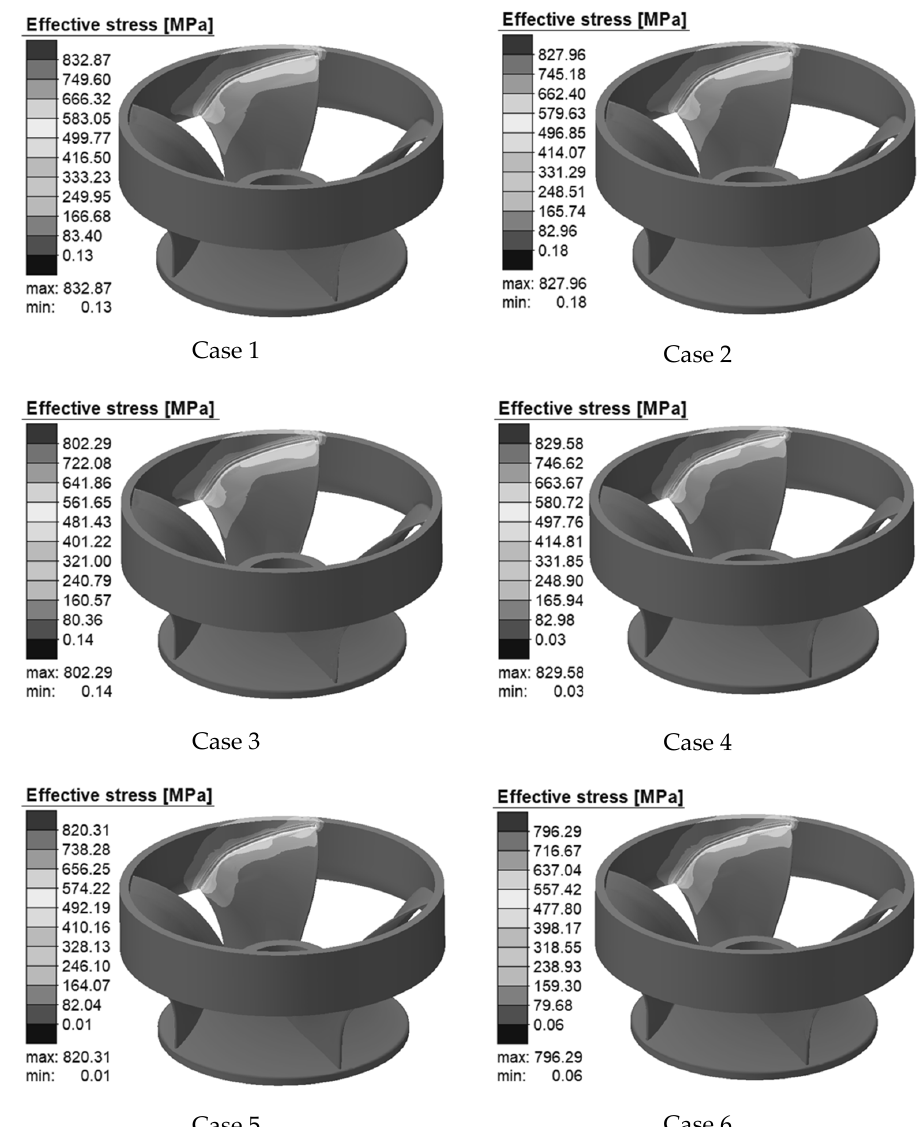
Figure 13. Von Mises stress distribution in each case.